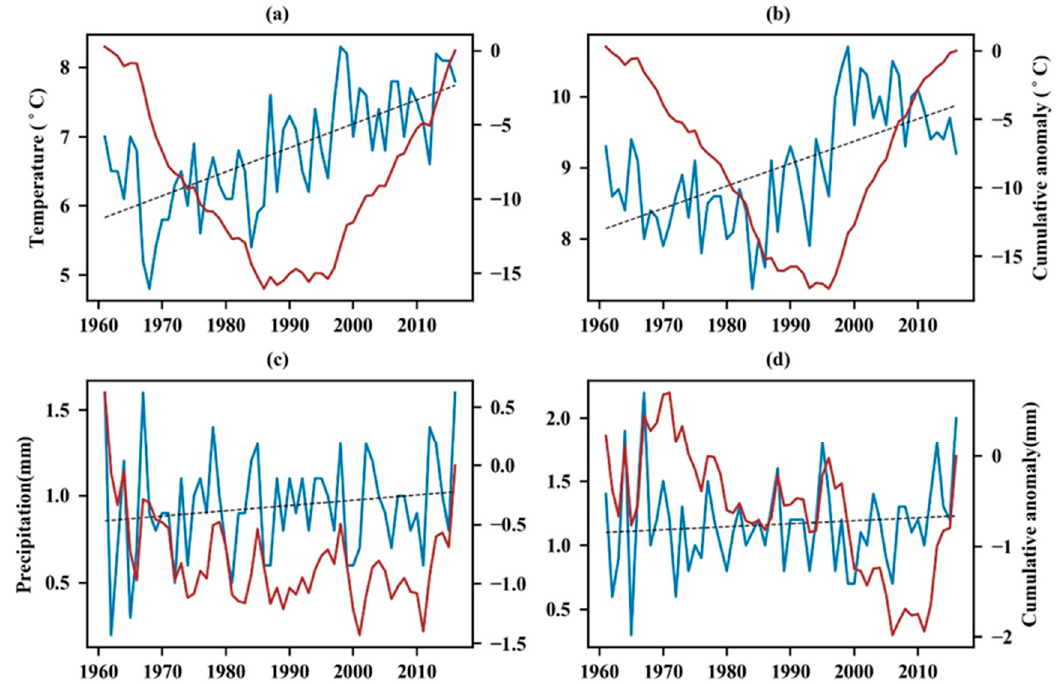
Figure 9. Temperature and precipitation trends for the Ejin Horo site and Shenmu site. ( a ) and ( b ) are the temperature trend and cumulative temperature anomaly for Ejin Horo and Shenmu, respectively. ( c ) and ( d ) are the precipitation trend and cumulative precipitation anomaly for Ejin Horo and Shenmu, respectively.